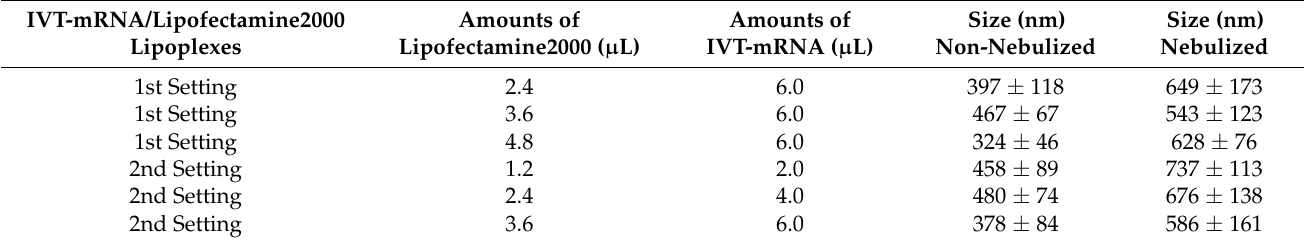
Table 1. Size of IVT-mRNA/Lipofectamine2000 lipoplexes.